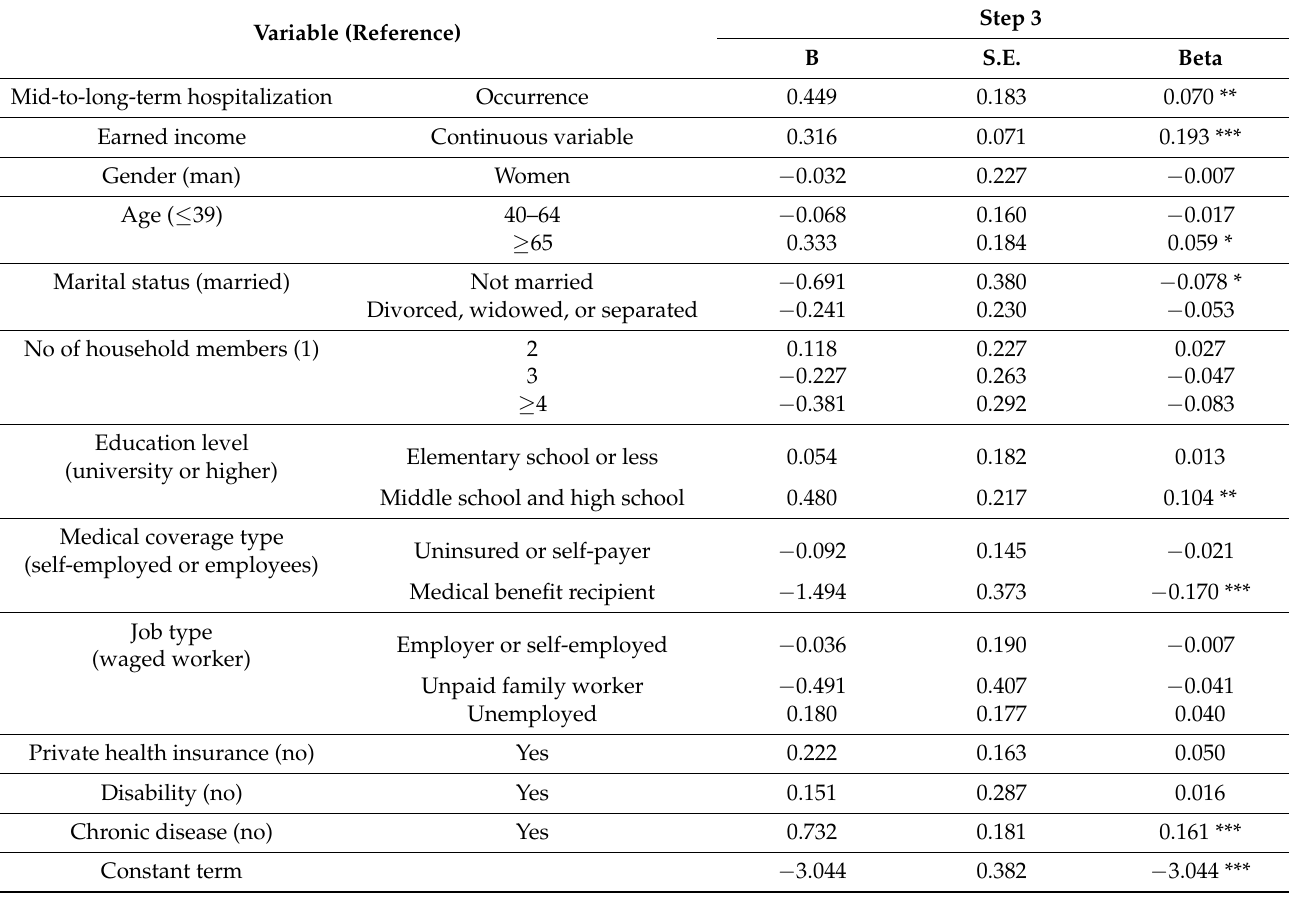
Table 5. The effect of income decline on the relationship between MLTH and